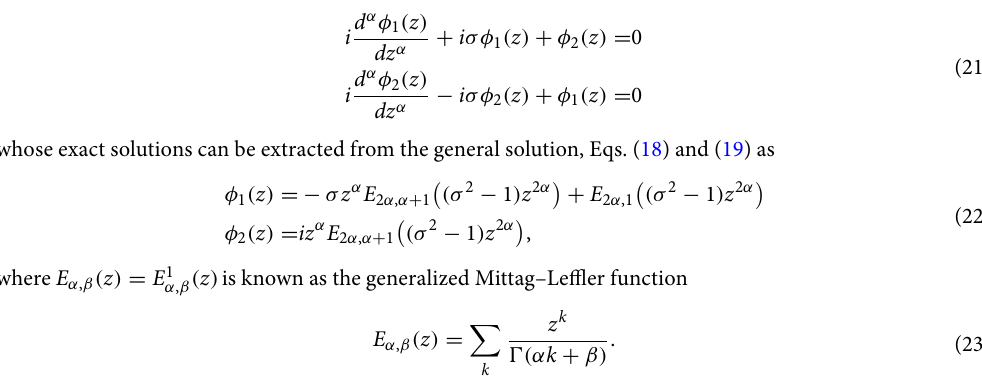
0 ) and several site energy parameters σ 1 , σ 2 and different = 2 ( 2 ) φ 1 φ 2 | | | |